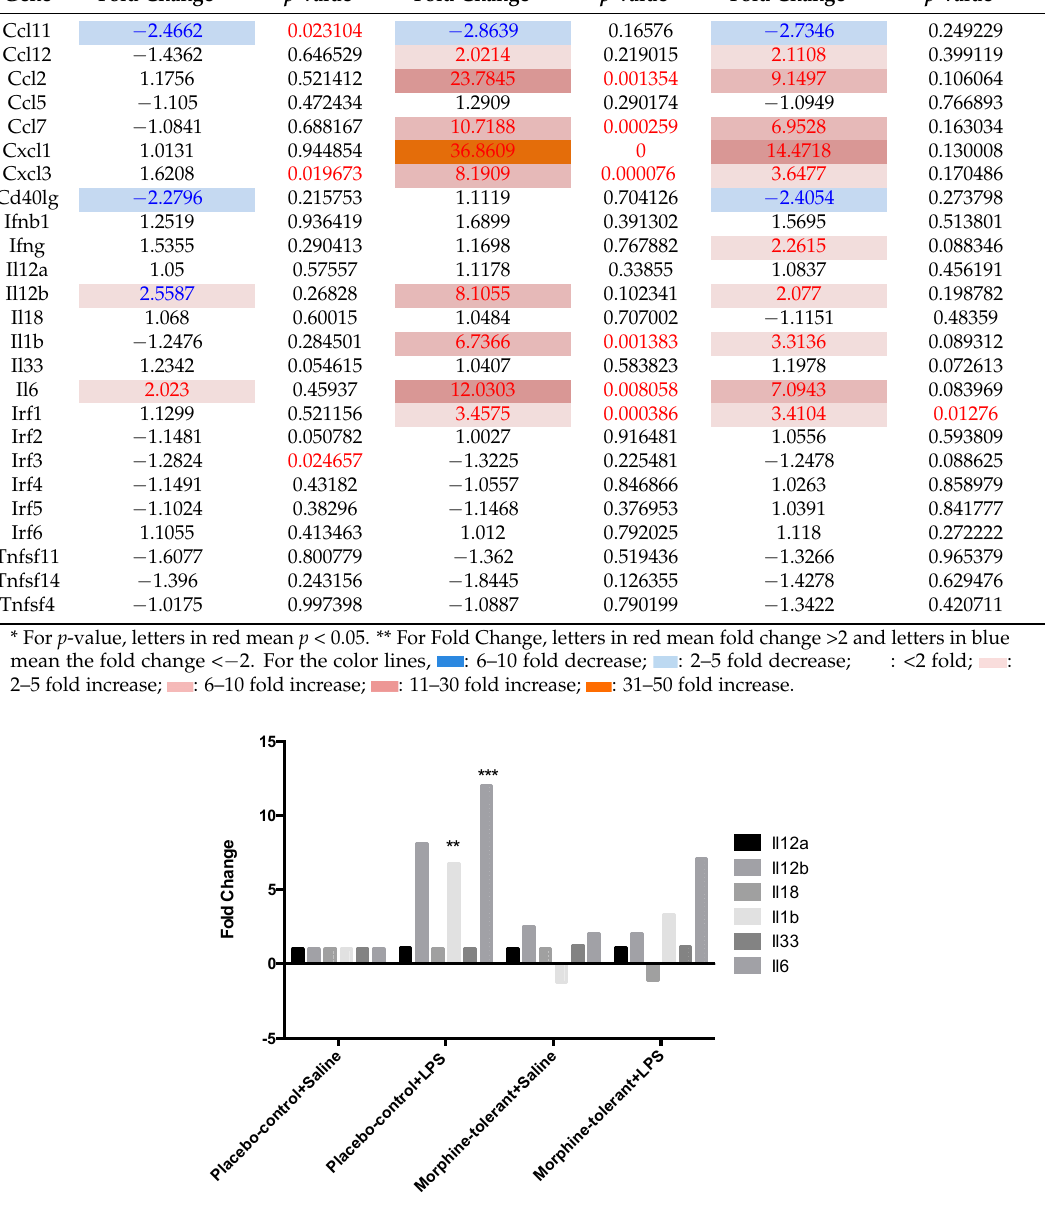
Figure 2. Inflammasome-related downstream gene expression in the rat brain in response to Lipopolysaccharides (LPS), with and without morphine tolerance. The expression of the inflammasome-related downstream signaling genes Baculoviral IAP Repeat-Containing 3 (Birc3) and NF-Kappa-B Inhibitor Alpha (Nfkbia) in the brains of rats given an i.p. injection of either 250 µg/kg LPS or saline, with and without morphine tolerance ( n = 3–5 rats per group), was determined using a Polymerase Chain Reaction (PCR) array. The data were calculated using the ΔΔ C T method relative to the control group (placebo-control + saline) and are represented as fold change.